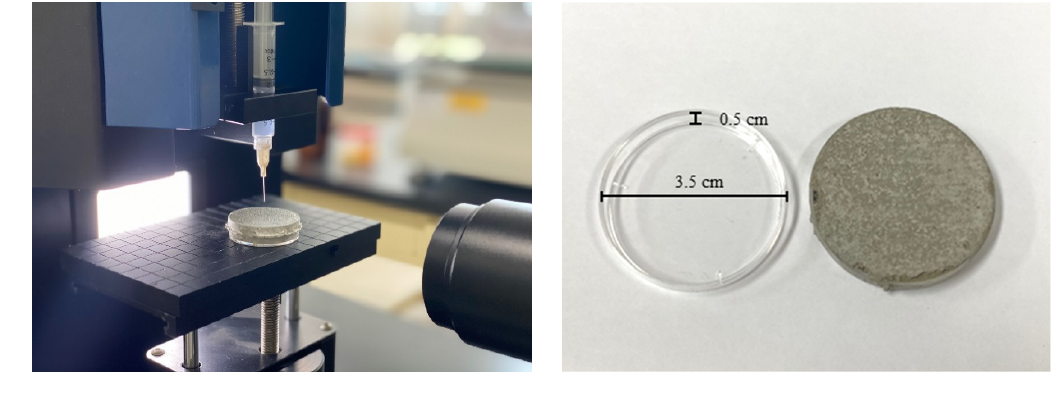
Figure 1. Water contact angle measurement process.